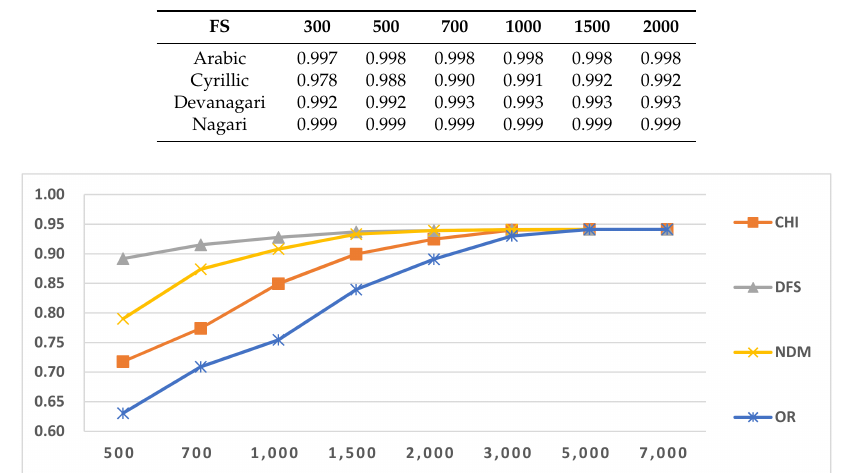
Table 13. Results of LI in non-Latin script languages when using SVM, distinguishing feature DFS and 2-gram.